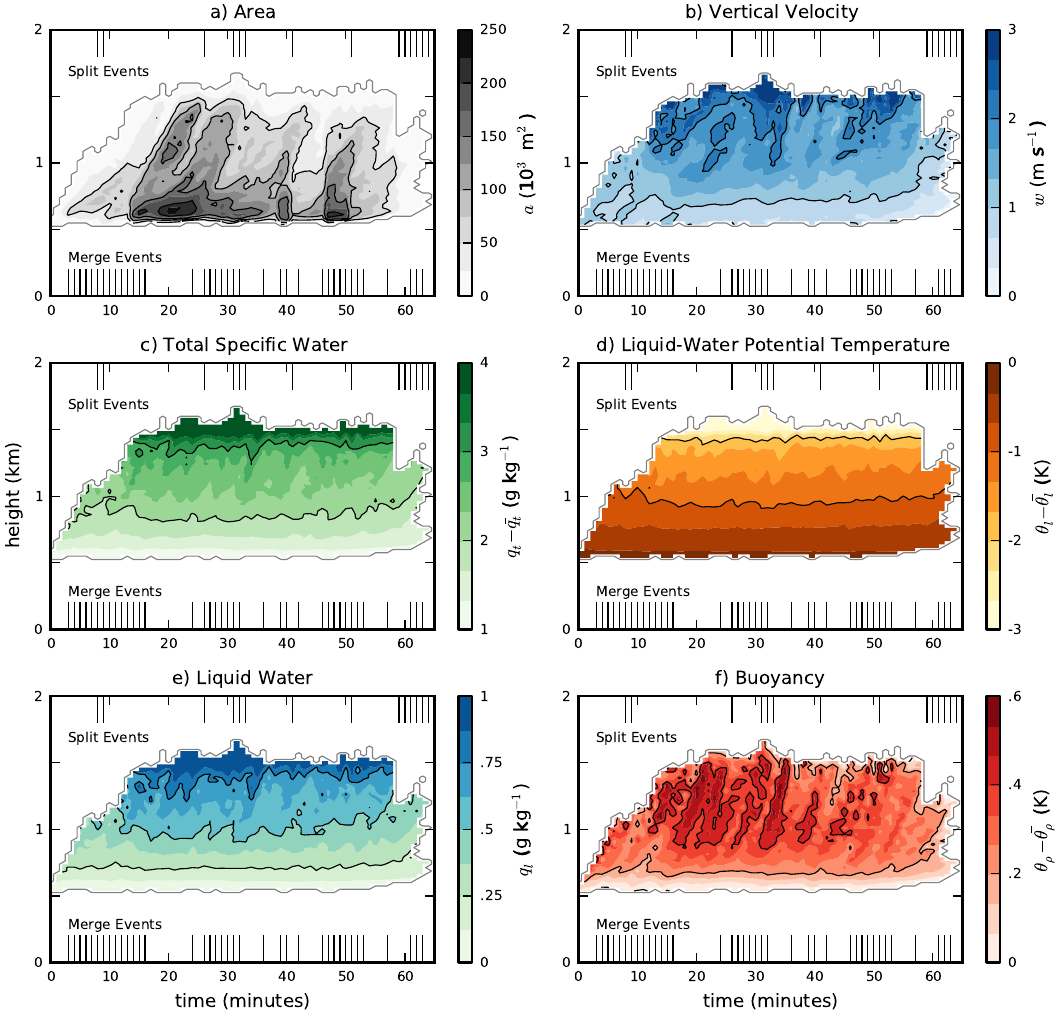
Fig. 5. As in as Fig. 4, but for the cloud core